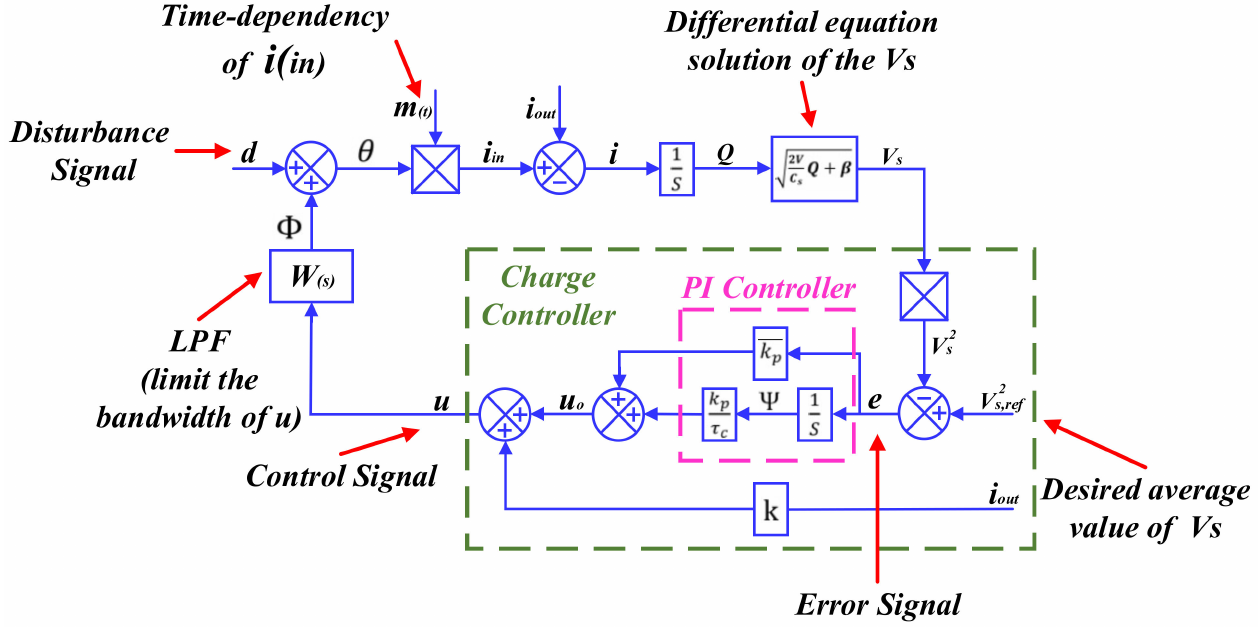
Figure 20. Control structure of a VIC charge controller, using a PI